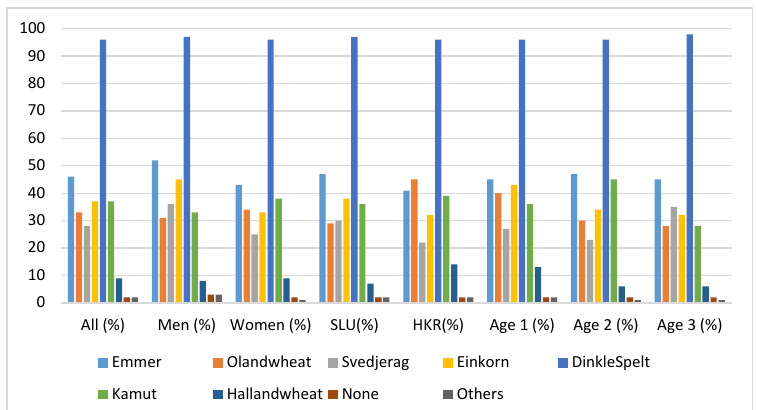
Figure 1. Frequency data given in percentages for each group showing the awareness of the different varieties of heritage cereals. The category “others” included black oat, quinoa, buck wheat, dala wheat, spring wheat, millet, naked oat, and te ff . Swedish University of Agricultural Sciences (SLU), Kristianstad University, Sweden